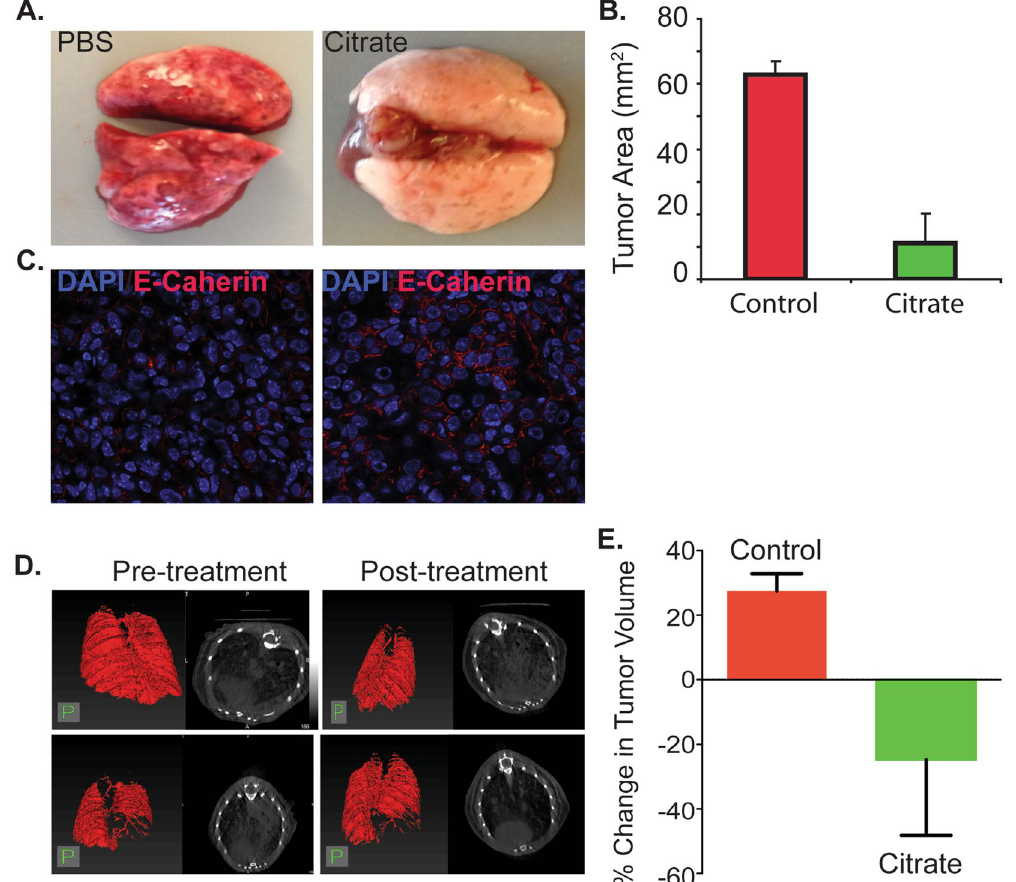
Figure 2. Citrate inhibits Ras driven mouse lung tumor growth in a genetic model. Ras G12D mice with lung tumor were treated with 4 g/kg citrate twice a day for 7 weeks. ( A and B ) Citrate treatment affects Ras G12D mouse lung morphology ( A ) and represses tumor growth ( B ). ( C ) citrate induces Ras-driven lung tumor differentiation as indicated by E-cadherin expression. Samples were collected and stained with anti-E-cadherin antibody. ( D ): CT scans on a representative Ras-driven lung tumor before and after citrate treatment. ( E ) Quantitative analysis of lung tumor growth, plotted as percentage change in tumor volume (Control: n = 3; Citrate: n =